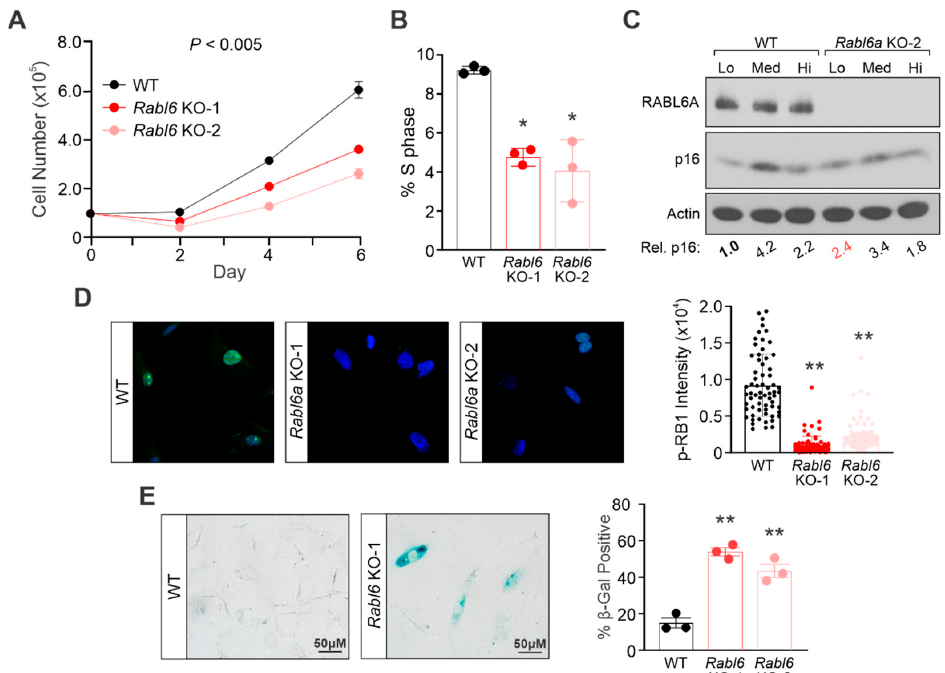
Figure 4 . Rabl6a-deficiency leads to reduced proliferative capacity in mouse embryonic fibroblasts. MEFs were harvested from wildtype (WT) or Rabl6 knockout (KO) mice and analyzed. ( A ) Growth curves from MEFs plated at equally low density and counted on days 2, 4, and 6 after plating. ( B ) Flow cytometric analyses of DNA content show a reduction in S phase in asynchronously growing Rabl6a KO MEFs as compared to WT. ( C ) Representative Western blot of sequentially passaged WT versus Rabl6 KO MEFs showing cells lacking RABL6A display elevated p16, a marker of senescence, earlier than WT. Below, quantified p16 levels from ImageJ densitometry analysis. ( D ) Representative immunofluorescence images of phospho-RB1 S807/811 (green) in low passage WT and Rabl6a KO cells, showing cells lacking Rabl6 activate RB1 earlier than WT. Nuclei stained with DAPI. Right, ImageJ quantification of fluorescent intensity of p-RB1. Dots represent individual cell nuclei. ( E ) Representative bright field images of β -galactosidase staining at the same passage number. Right, quantification from three or more experiments of β -galactosidase positive cells, showing an increase in Rabl6a knockout MEFs versus WT. ( A ) p value determined by a generalized linear model to assess the difference between the curves. Error bars, SD from mean. ( B , D , E ) p value, One-way ANOVA with Dunnett’s correction. (*, p < 0.05; **, p < 0.001).